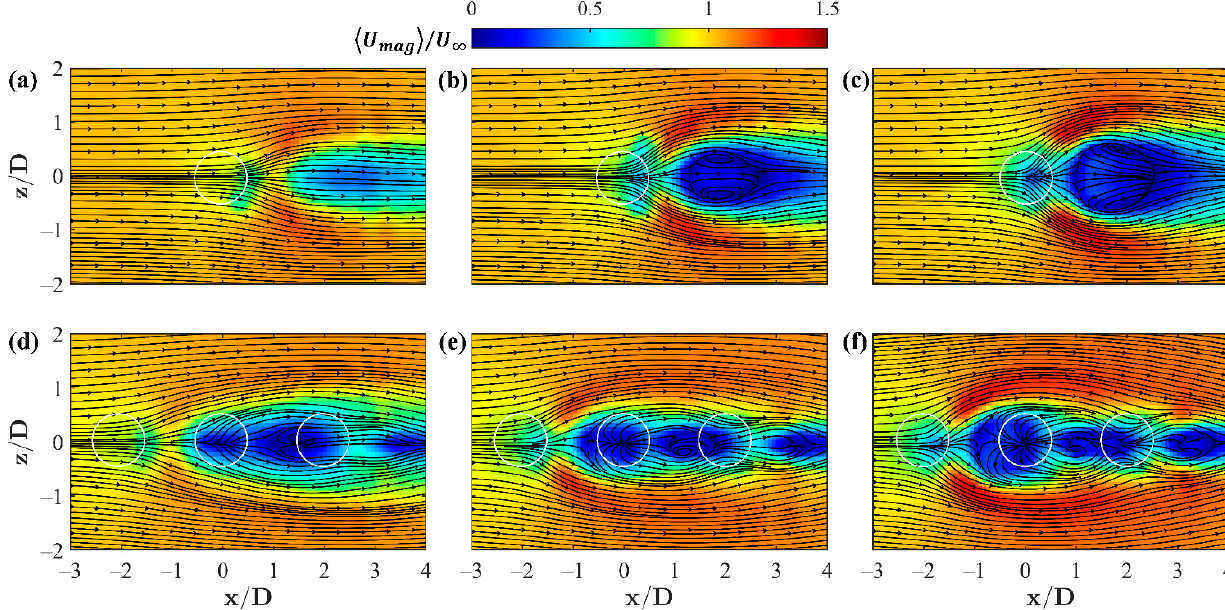
(cid:10) (cid:11) Figure 4. Time-averaged velocity magnitudes U mag /U ∞ with velocity streamlines. Rows depict ( a – c ) single and ( d – f ) triple jets with white circles and columns ( a , d ), ( b , e ), and ( c , f ) correspond to V j /U ∞ = 0.9, 1.25, 1.7, respectively. Reproduced with permission from Kristo and Kimber, Time-resolved particle image velocimetry measurements of a tandem jet array in a crossflow at low velocity ratios [15]; published by Springer Nature,